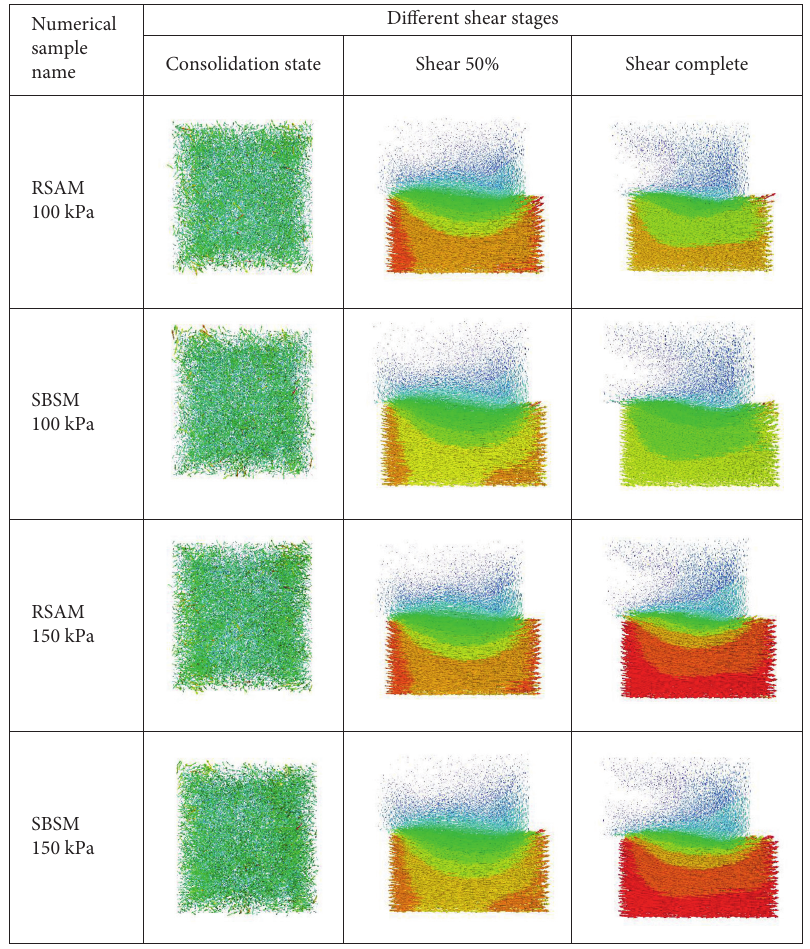
Figure 9: Variation of displacement field in the shear process of two kinds of numerical samples with different roundness of